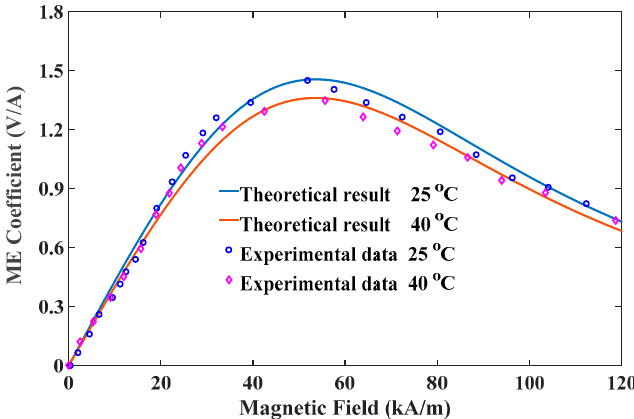
Figure 2. Comparison of variation of the ME coefficient at various operating temperatures.